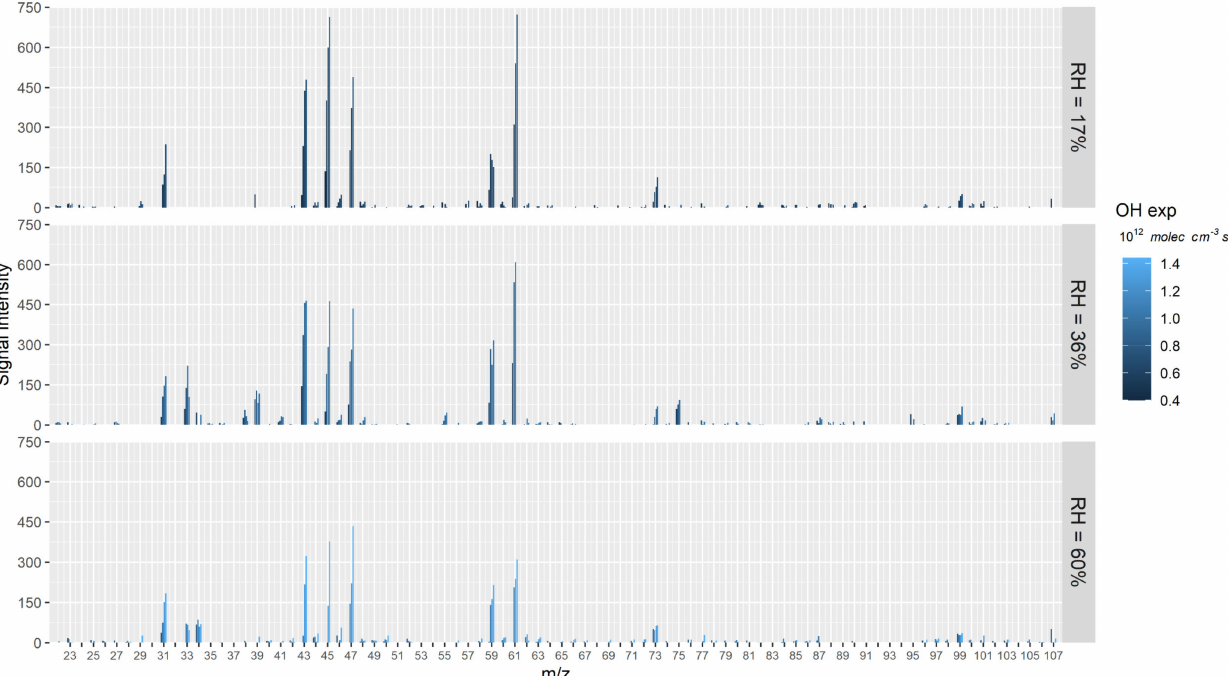
Figure 2. Mass spectrum of gas phase products observed in experiments without seed particles. All the spectrums shown are background (OH exposure = 0)